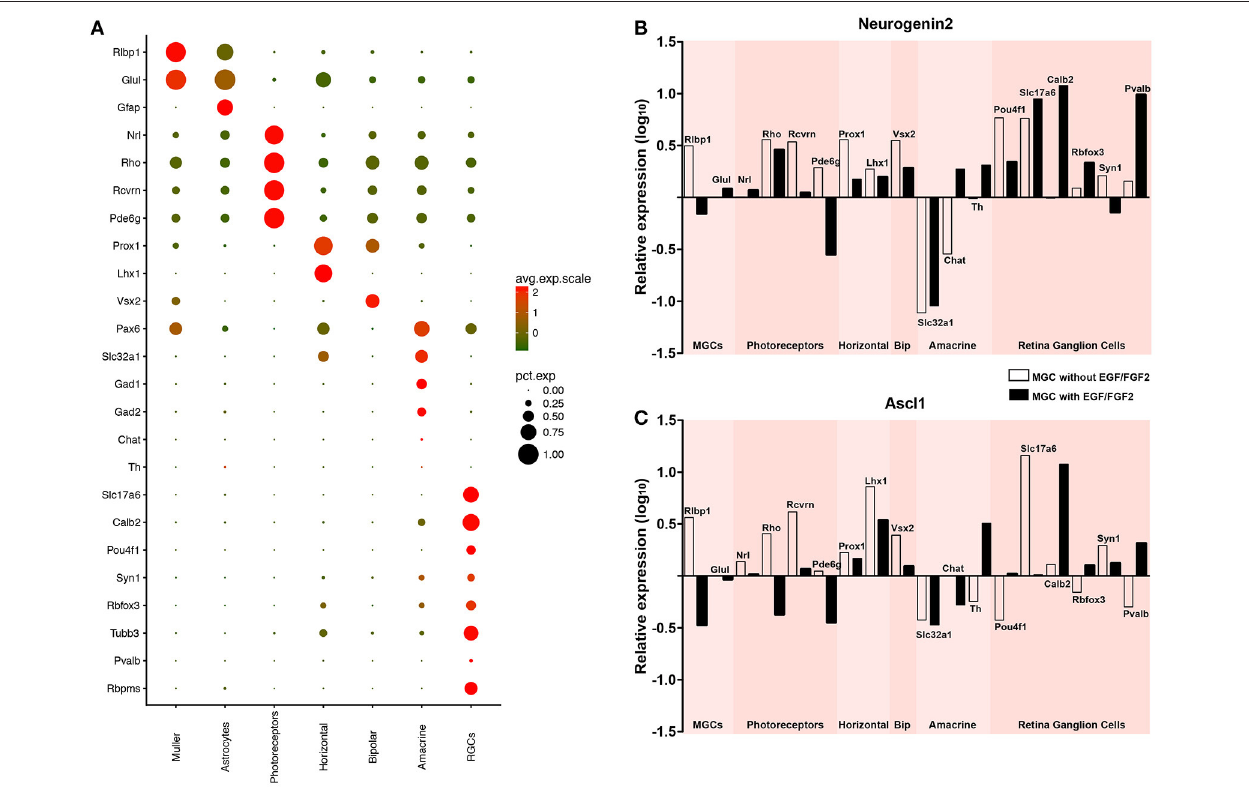
FIGURE 5 | Expression of either NEUROG2 or ASCL1 induces upregulation of key retina neuron genes in MGC-derived iNs. (A) Expression levels of selected genes used to identify different classes of retina neurons using scRNAseq data available in the literature ( Macosko et al., 2015) (see also Figure S2 ). Dot sizes and colors (green-low to red-high) represent the percentage of cells expressing the gene and its average scaled expression, respectively. Observe that the expression of Slc17a6 and Pou4f1 are specific for a high percentage of cells assigned as RGCs. (B,C) Graphics showing the relative expression levels (log 10 ) of genes enriched in Müller glia (Rlbp1, Glul), photoreceptors (Rho, Rcvrn, Pde6g), horizontal (Prox1, Lhx1), bipolar (Vsx2), amacrine (Slc32a1, Chat, Th) and retina ganglion cells (Pou4f1, Slc17a6, Calb2, Rbfox3, Syn1, Pvalb, Rbpms), as shown in (A) , in MGC cultures nucleofected with either Neurog2 (B) or Ascl1 (C) . White and black bars indicate that MGC were expanded in the absence or presence of EGF/FGF2, respectively, prior to the expression of Neurog2 or Ascl1.